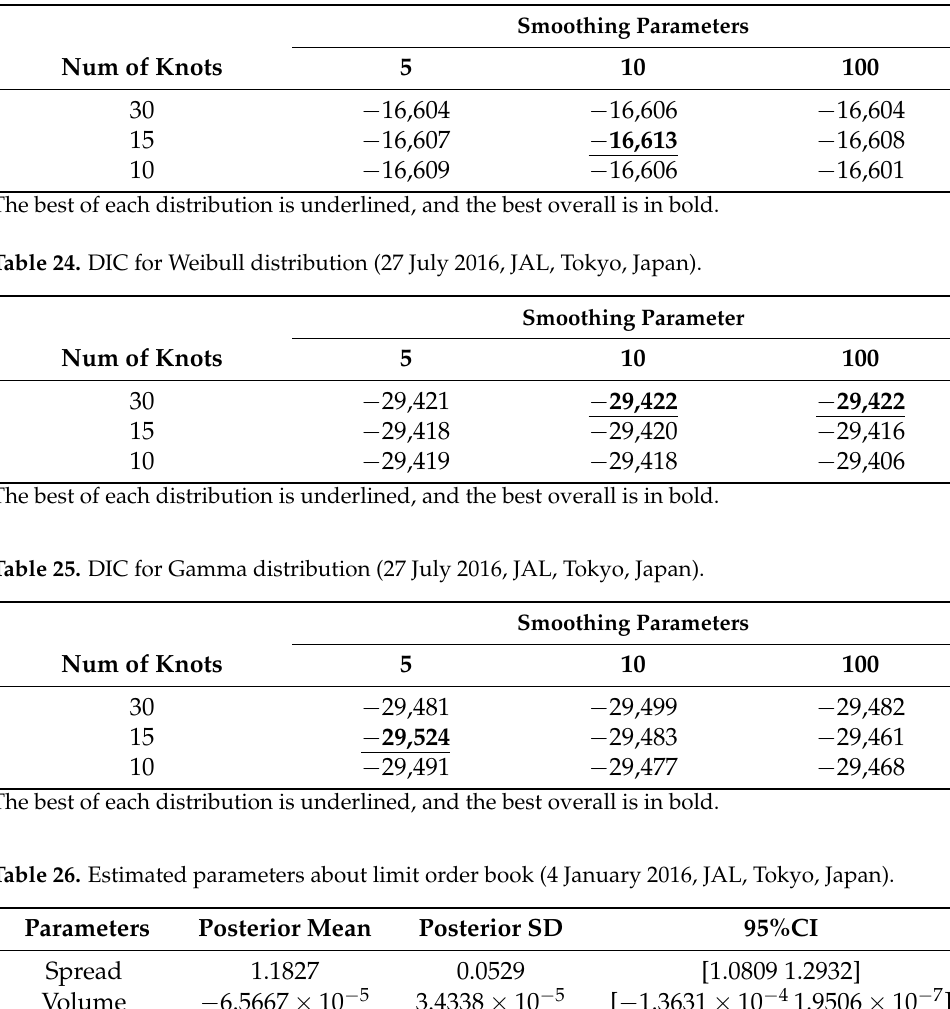
The best of each distribution is underlined, and the best overall is in bold. Table 23. DIC for Gamma distribution (23 June 2016, JAL, Tokyo, Japan). Smoothing Parameters